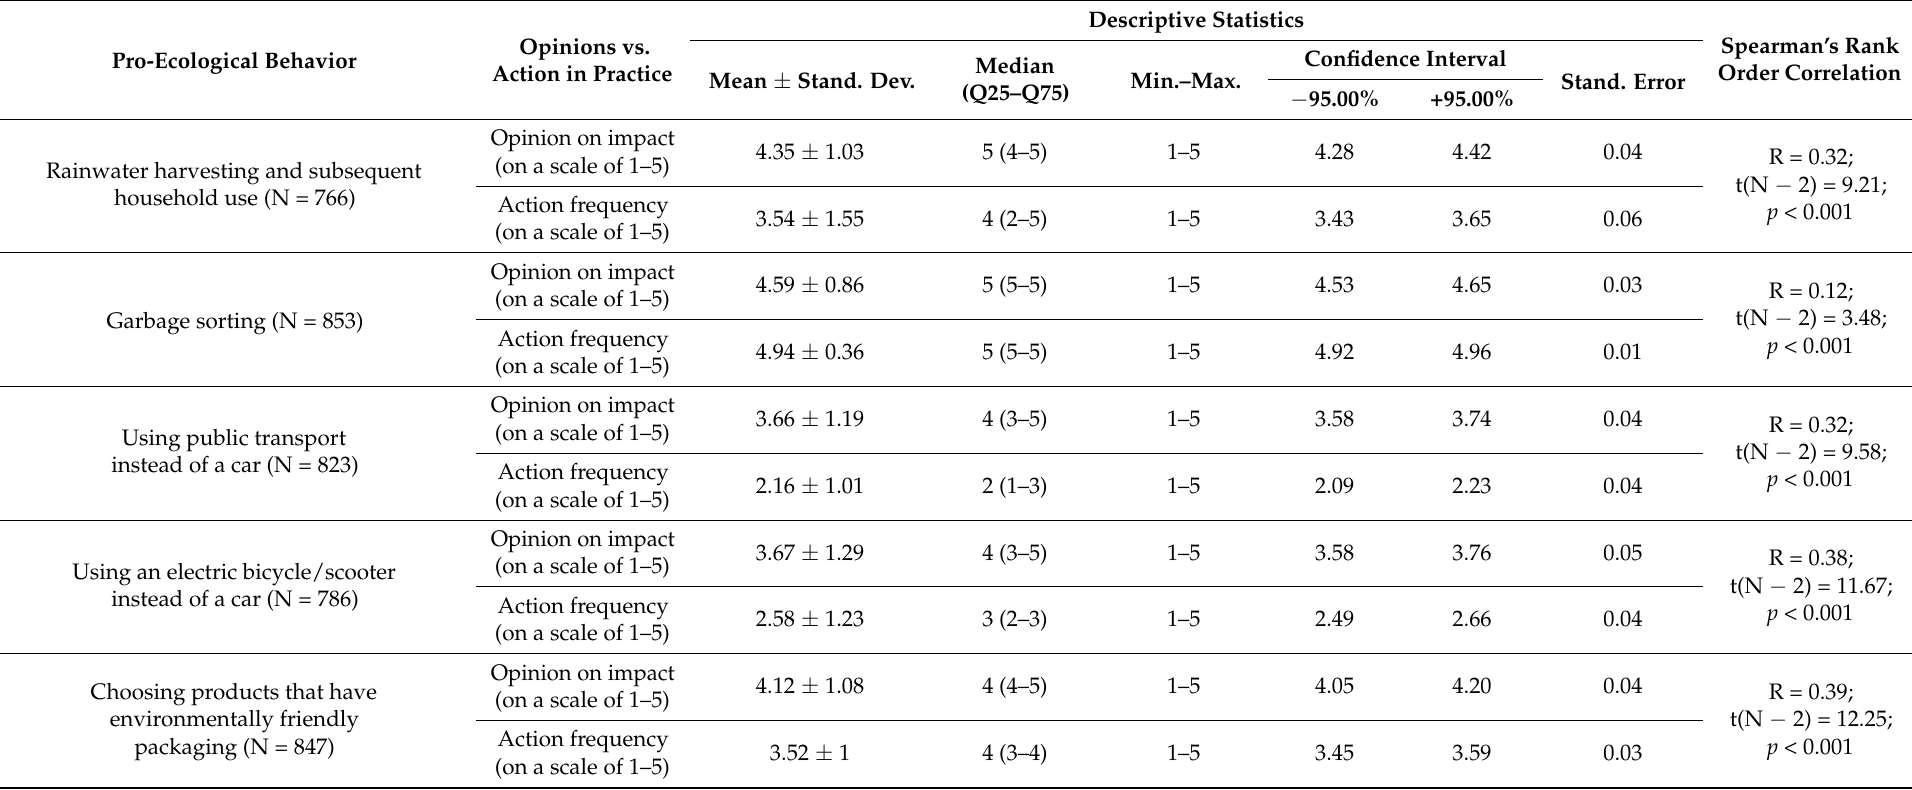
Table 8. Relationship between respondents’ opinions on the degree of the positive impact of particular pro-ecological behaviors on the environment and their undertaking of these